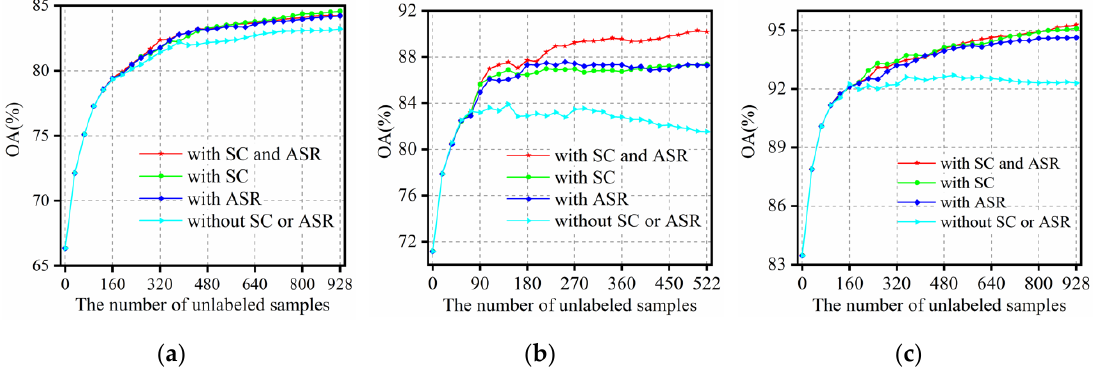
Figure 13. OAs as a function of the number of unlabeled samples obtained by using different strategies to ensure confidence for the ( a ) Indian Pines dataset, ( b ) Pavia University dataset, and ( c ) Salinas Valley dataset.